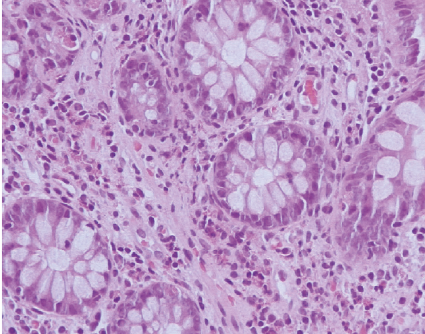
Figure 5: Colon biopsy with > 20